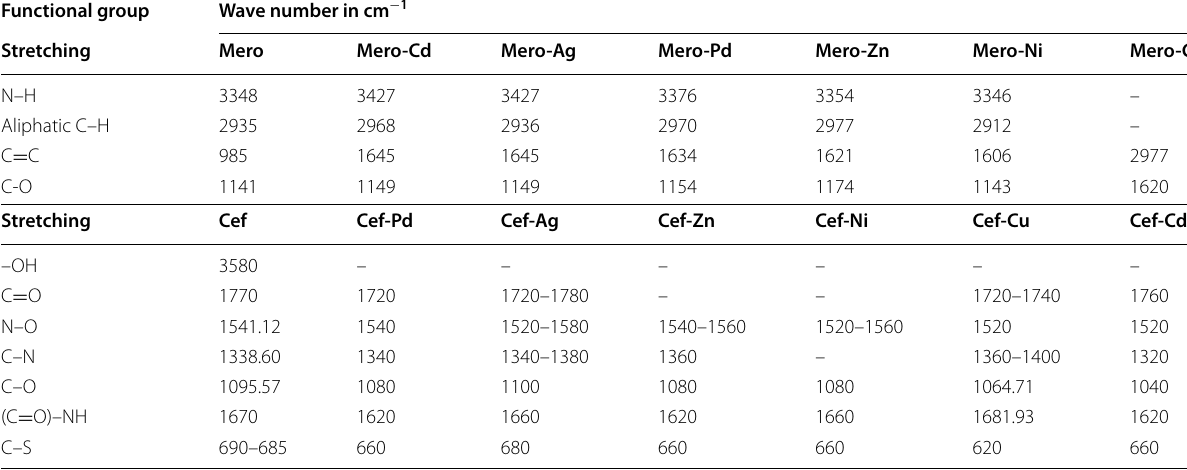
Table 1 FTIR peaks of meropenem, cefixime and its synthesized complexes Functional